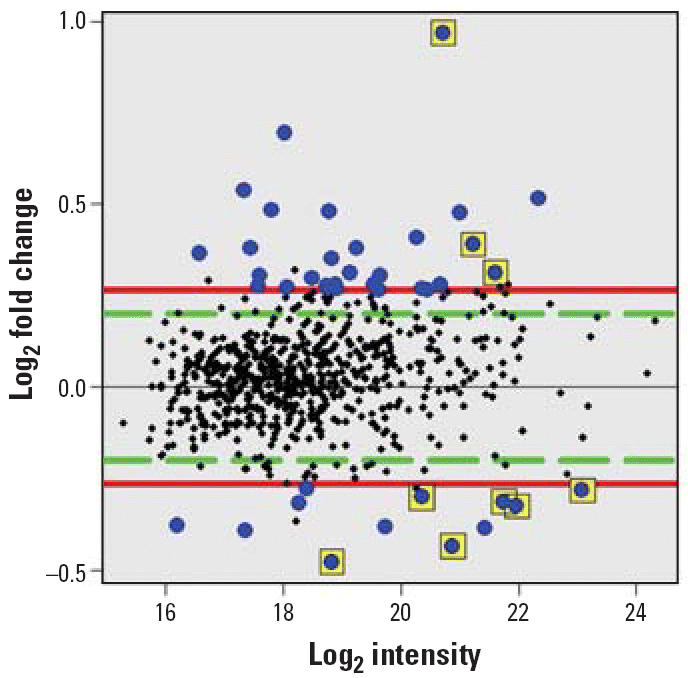
Measurement of relative expression versus average log intensity (MA) plot showing the result of the statistical analysis of the striatum proteins. The log2 values of spot intensity on the y-axis are plotted against log2 values of fold change on the x-axis. The intensity was calculated as the log2 of the raw intensity of the average of Cy3 and Cy5 across all four gels. The spots correspond to the striatum proteins identified on all four DIGE gels. The spots marked in blue represent the differently regulated proteins, whereas the squared blue spots represent the nine proteins picked and identified from the striatum gel 4.